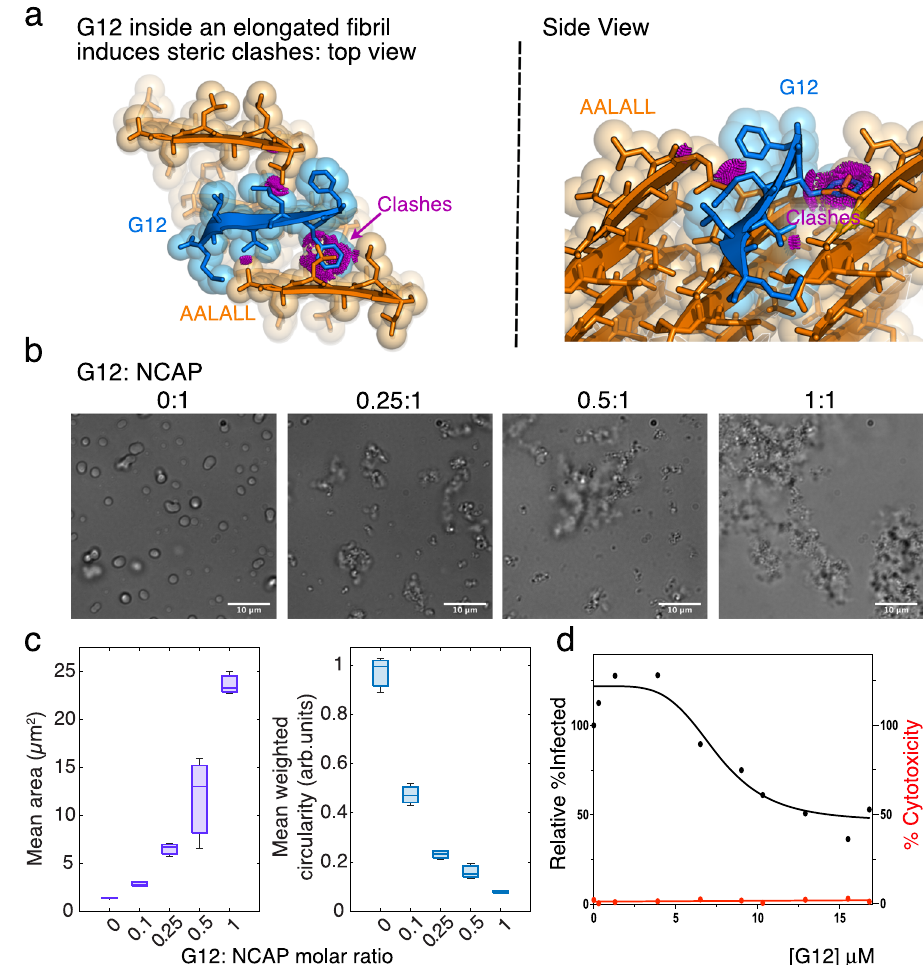
Fig. 5 | Design and evaluation of NCAP ’ s self-assembly disruptor, G12. a The Rosetta-baseddesignofG12templatedbytheAALALLX-raycrystalstructureform1 (Fig.4;Table1).ModeloftheG12(blue)cappinganAALALL fi bril(orange).Thetop view is down the fi bril axis and the side view is tilted from the axis. Additional AALALL strands are shown adjacent to the bound G12 to illustrate their steric clashes (magenta). b Differential interference contrast (DIC) images of NCAP+ S2hp mixtures incubated in the absence (0:1) and presence of increasing con- centrations ofG12 revealing the PS disrupting activity of G12. c Meanarea (purple) and mean circularity (blue; normalized to particle size) of droplets and particles quanti fi ed from a series of light microscopy images of NCAP+S2hp mixtures with increasing concentrations of G12. The experiment was performed in three